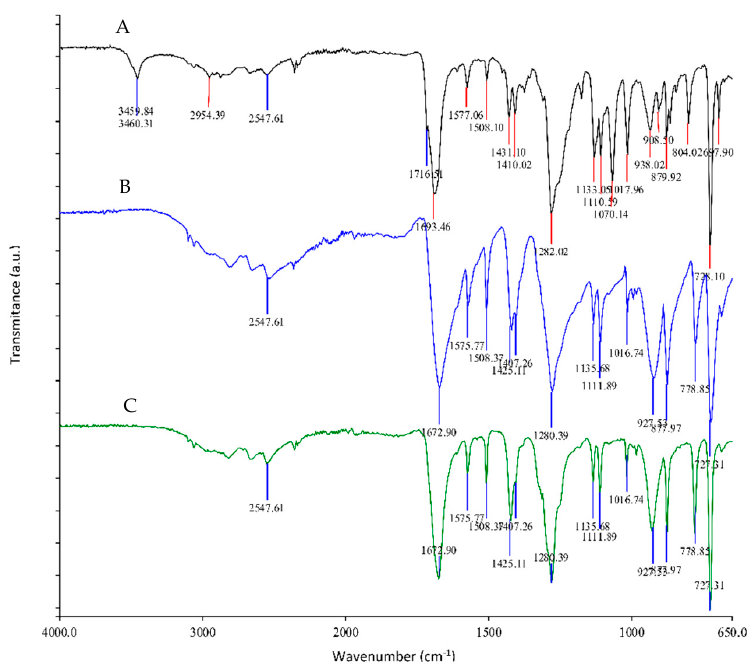
Figure 7. ATR–FTIR spectra of commercially available pure TPA (B spectrum), isolated solid frac- tion after neutral hydrolysis of PET foil coated with chitosan (A spectrum), and purified product (C spectrum).